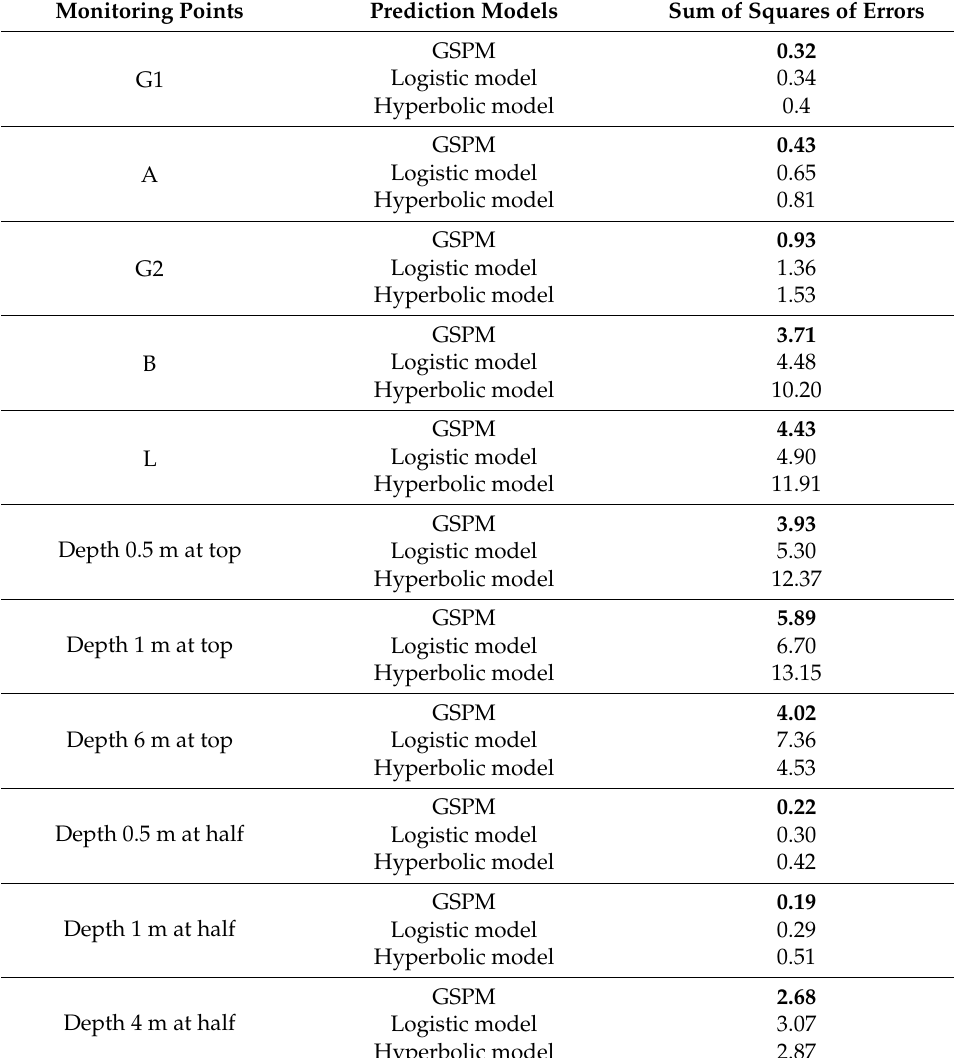
Table 7. Sum of squares of errors for different settlement–time models unit:mm 2